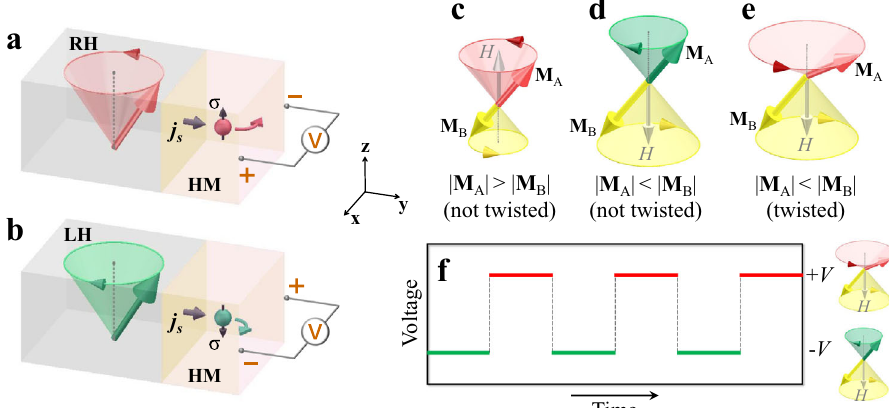
Fig. 1 Schematic of chirality-dependent spin pumping. Magnetization precessions with ( a ) right-handed (RH) and ( b ) left-handed (LH) chiralities around the equilibrium axis ( + z axis) pump spin current into a heavy metal (HM) layer. The chirality is de fi ned by the precessing magnetization and the equilibrium direction. The DC voltage polarity detects the spin polarization ( + z or − z ) of the spin current. Here only sketches the Py magnetization precession of the outermost Py layer in Py/Gd multilayer. c – e sketch the magnetization precessions of two magnetic sublayers M A and M B with AFM coupling. When M A and M B are collinearly aligned, as shown in c , d , magnon chirality can be switched between RH and LH by resizing M A and M B . LH chirality of M A precession in d can be switched to RH chirality in e by twisting M A and M B into a twisted state. f By twisting M A and M B recurrently, the magnon chirality can be modulated and read out in form of the spin pumping